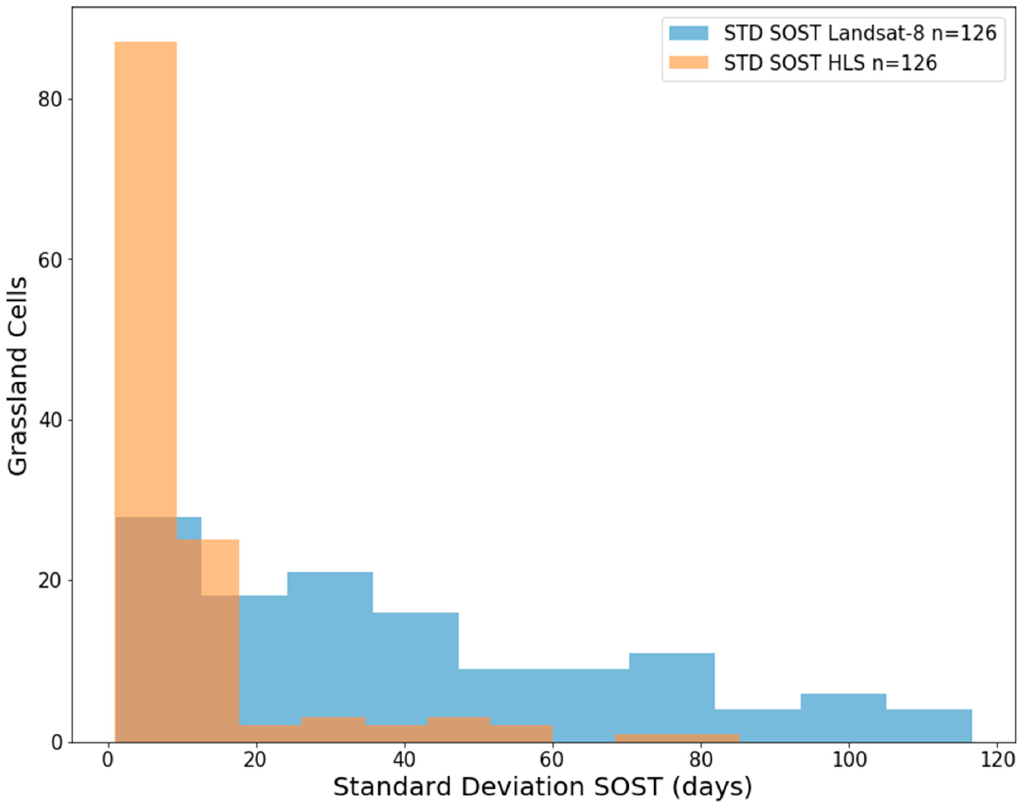
Figure 6. The distribution of SOST standard deviation (STD) for grassland pixels calculated from time series Landsat-8 and HLS.